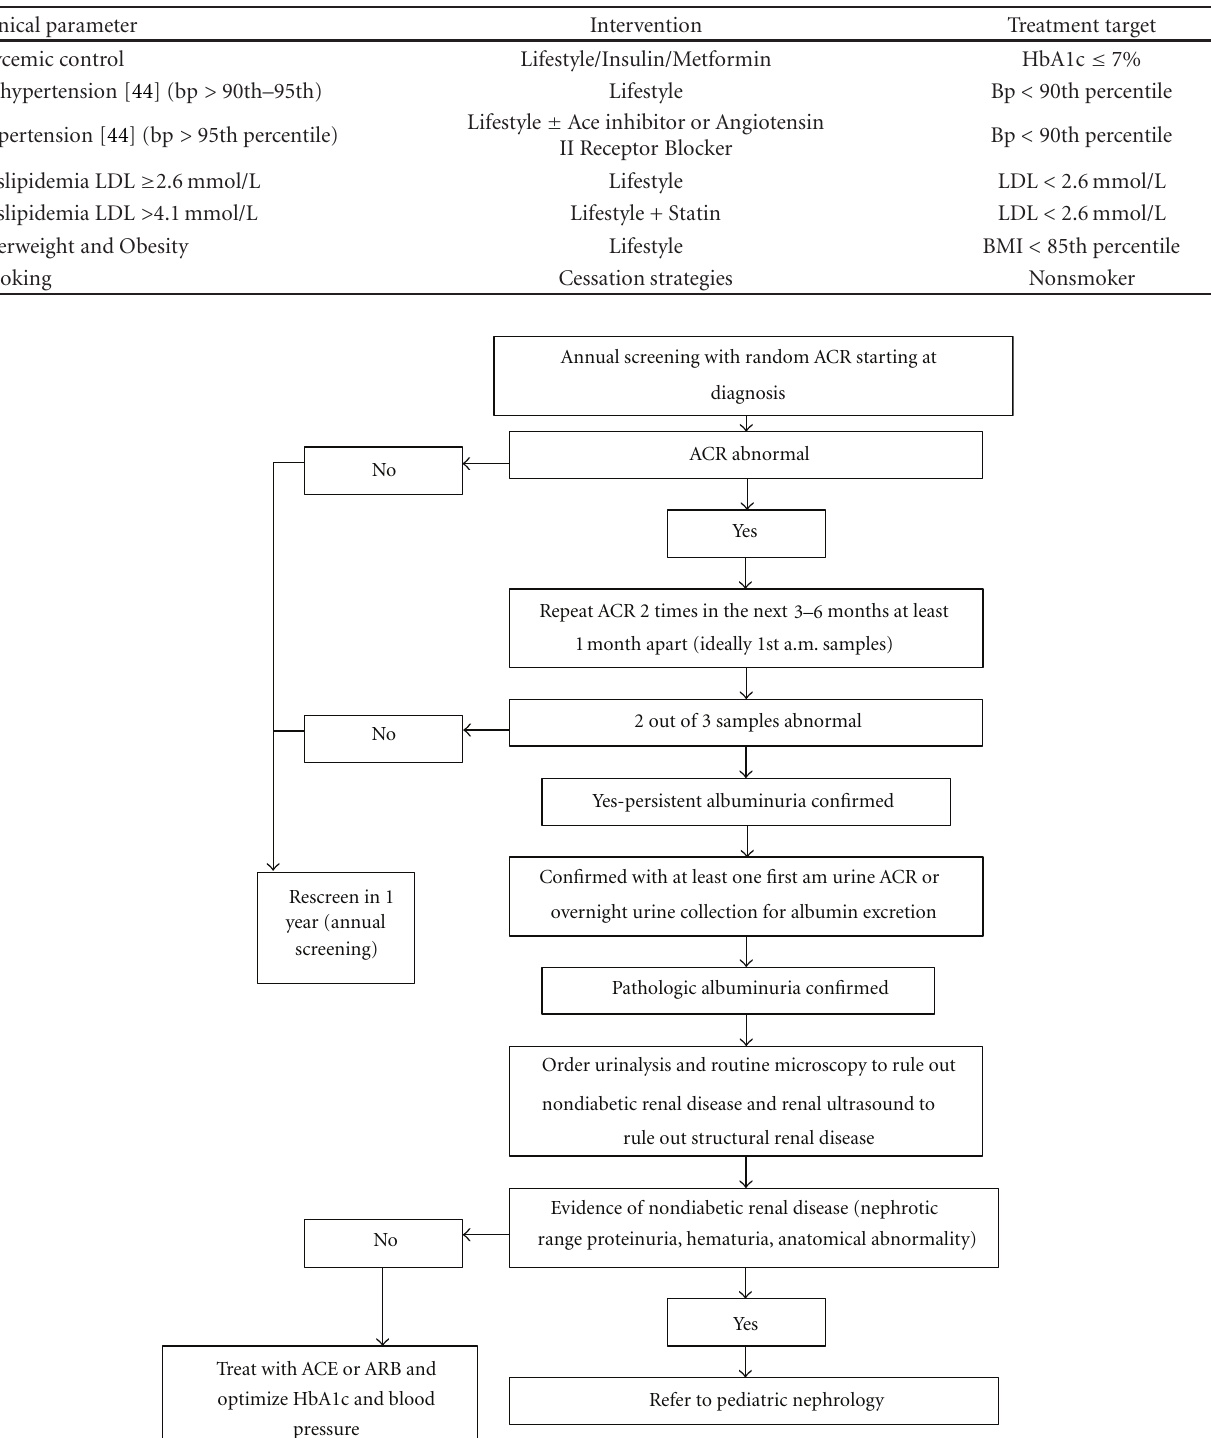
Table 2: Recommended treatment targets that may reduce risk of nephropathy in youth with type 2 diabetes.